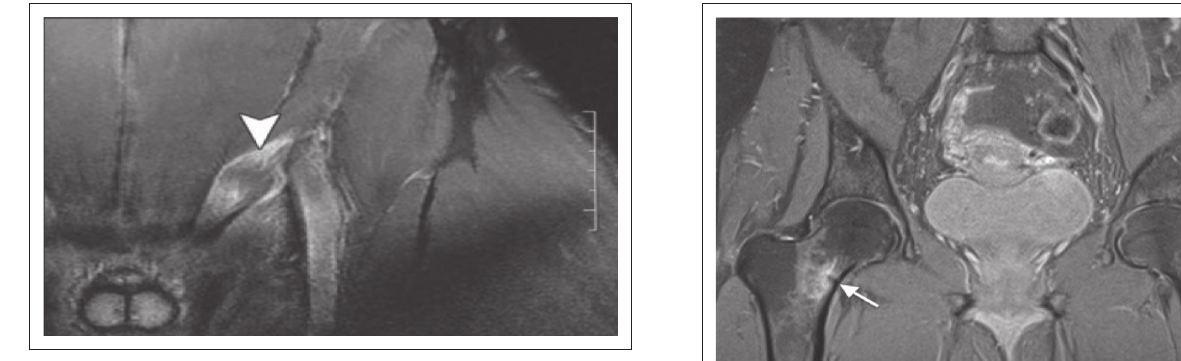
FIGURE 8: Anterior inguinal wall deficiency. Coronal T2-weighted fat-saturated image through the anterior abdominal wall of an elite 28-year-old male Australian-rules football player shows area of increased hyperintensity of left external inguinal ring, consistent with traumatic disruption of most medial fibres of the external oblique aponeurosis (arrowhead) and therefore in keeping with acute disruption of anterior inguinal wall. (Reprinted with permission from the American Journal of Roentgenology ).